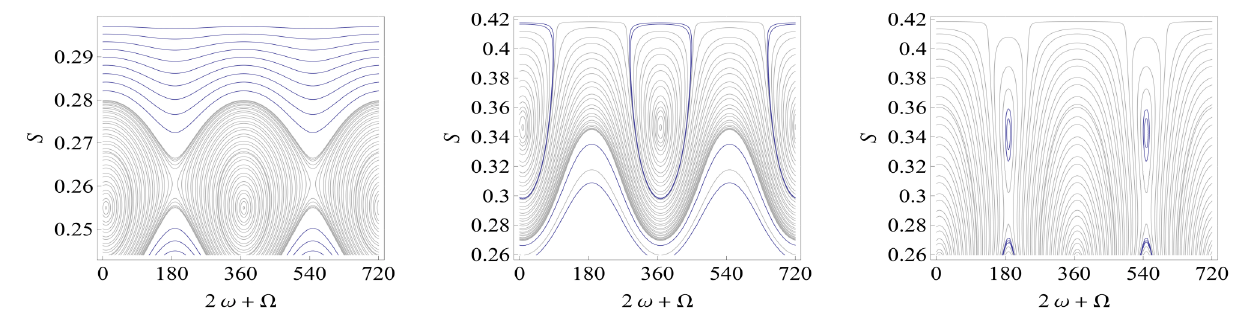
FIGURE 2 | Phase space portraits for a = 15 , 000 km and T = 0.03 (left panel), a = 29 , 546 km and T = 0.05 (middle panel), a = 29 , 546 km and T = 0.03 (right panel).